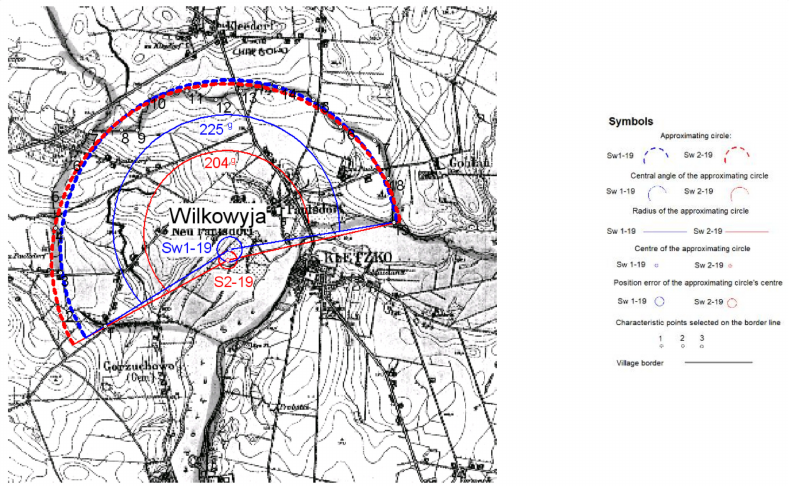
Figure 6—Szemborowo, Figure 7—Gołaszewo, Figure 8—Lubochnia, Figure 9—Glinka, Figure 10—Ryszewo, Figure 11—Łopienno, Figure 12—Grochowiska, Figure 13—Popowo, Przysieka, Figure 14—´Swiniary, Figure 15—Modrze).